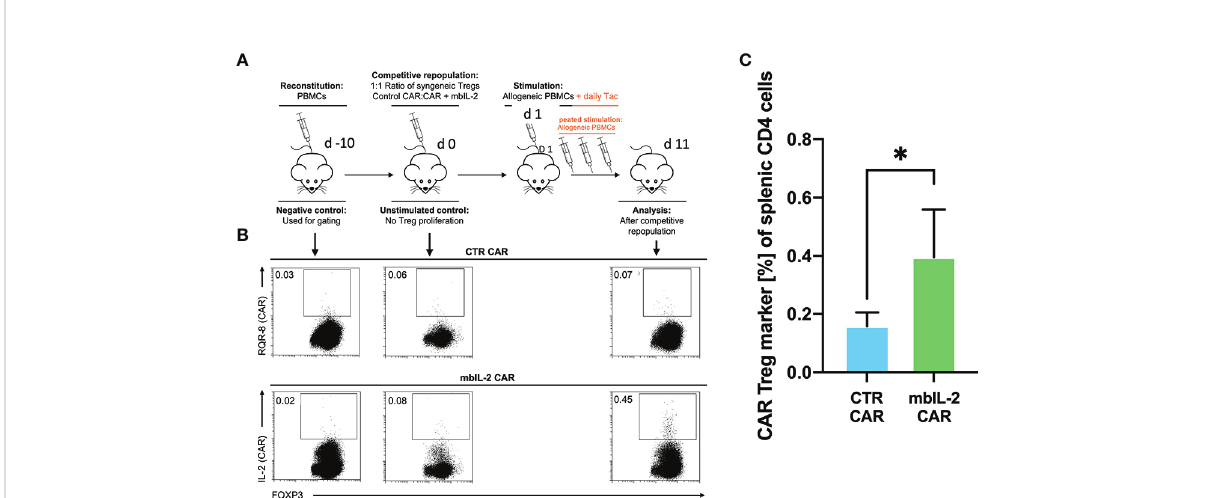
FIGURE 9 mbIL-2 enabled CAR-Treg resistance to calcineurin inhibitors in a preclinical humanized mouse model. (A) Experimental setup. On Day -21, NRG mice were reconstituted with HLA-A*02negative PBMCs. Differently labelled syngeneic mbIL-2 CAR and CTR CAR-Tregs were adoptively transferred at a 1:1 ratio. To ensure a continued allogeneic stimulus, animals received allogeneic HLA-A*02-positive PBMCs three times weekly. The scenario of maintenance therapy with CNI was mimicked by treating the animals daily with Tac (5 mg/kg). This resulted in an IL-2-poor/free environment. Spleens were isolated and analysed on day 10. (B) Representative dot plots show the decreasing fraction of CTR CAR-Tregs in the spleens of animals compared with that of mbIL-2 CAR-Tregs in this experimental scenario. The CAR-Treg gate was established according to the unstimulated negative control in animals killed one day after adoptive CAR transfer. It was found that 87% of all adoptively transferred cells could be assigned to the mbIL-2 CAR-Treg repertoire with autocrine IL-2 signalling and 13% to the CTR CAR-Treg repertoire. (C) Bars summarize the data from all experiments and illustrate the decreasing fraction of CTR CAR-Tregs compared with that of mbIL-2 CAR-Tregs. The proportion of CAR-Tregs that could be assigned to the mbIL-2 modi fi cation population (0.40% +/- 0.16%) was more than twice that of the CTR CAR population (0.16% +/-0.05%). n=4 of different experiments. Signi fi cance was calculated using an unpaired t test. Error bars show the mean ± SD. p*